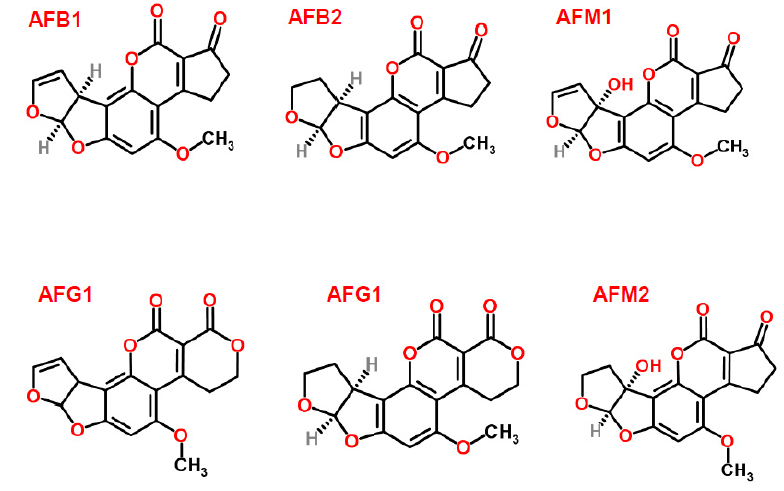
Figure 1. Chemical structures of aflatoxins (structures from www.chemspider.com).